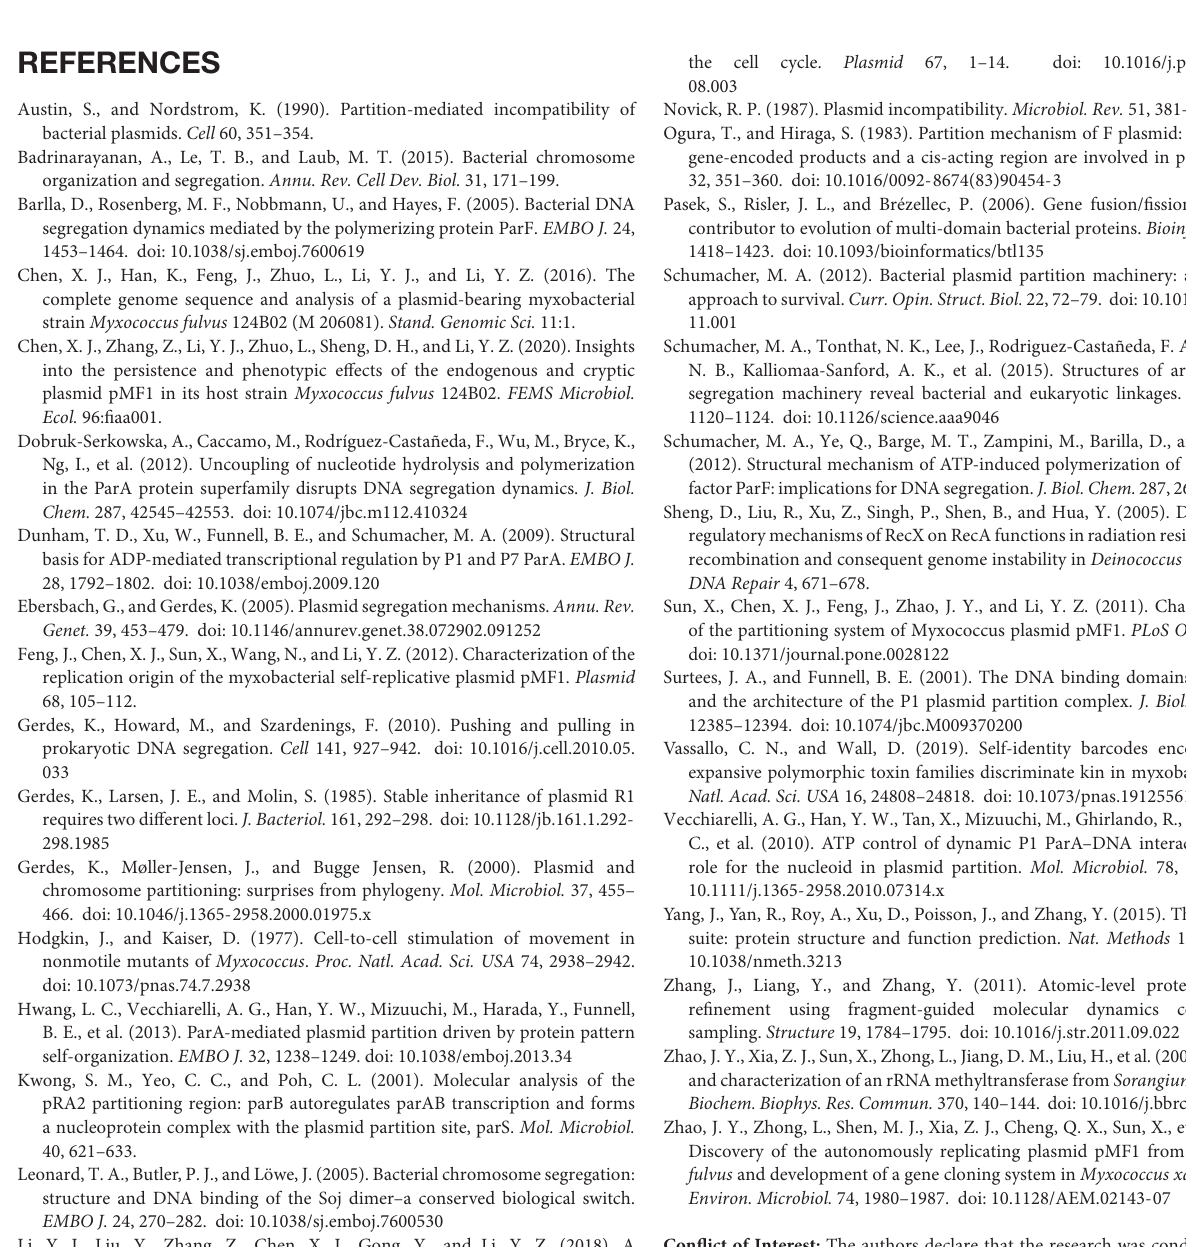
Supplementary Table 1 | Function annotation of the pMF1 genes in GenBank and the homologous gene sources with the highest similarity. Supplementary Table 2 | Bacterial strains and plasmids used in this study. Supplementary Table 3 | Primers used in this